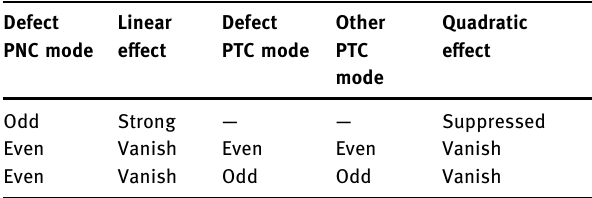
Table 4: Linear and quadratic couplings depend on symmetry of the defect PNC mode, the defect PTC mode, and the other PTC